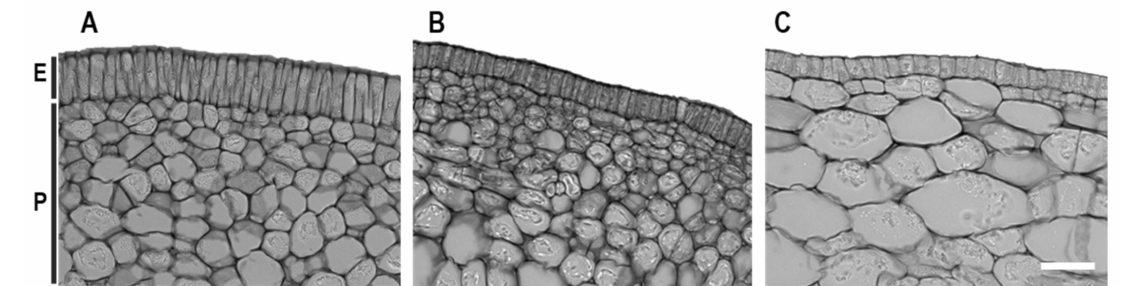
Figure 6. Light microscope images show 10 µ m cross-sections of control ( A ), CGMMV-infected ( B ) and ZYMV-infected ( C ) pasteurized C. sativus fruits of comparable size and age. ZYMV-infected parenchymal cells (P) are highly enlarged, whereas epidermal cells (E) show a shortened, thickened shape compared to control. The epidermal cells of CGMMV-infected cucumbers also appear smaller, whereas parenchymal tissue is comparable to the control. Scale bar = 40 µ